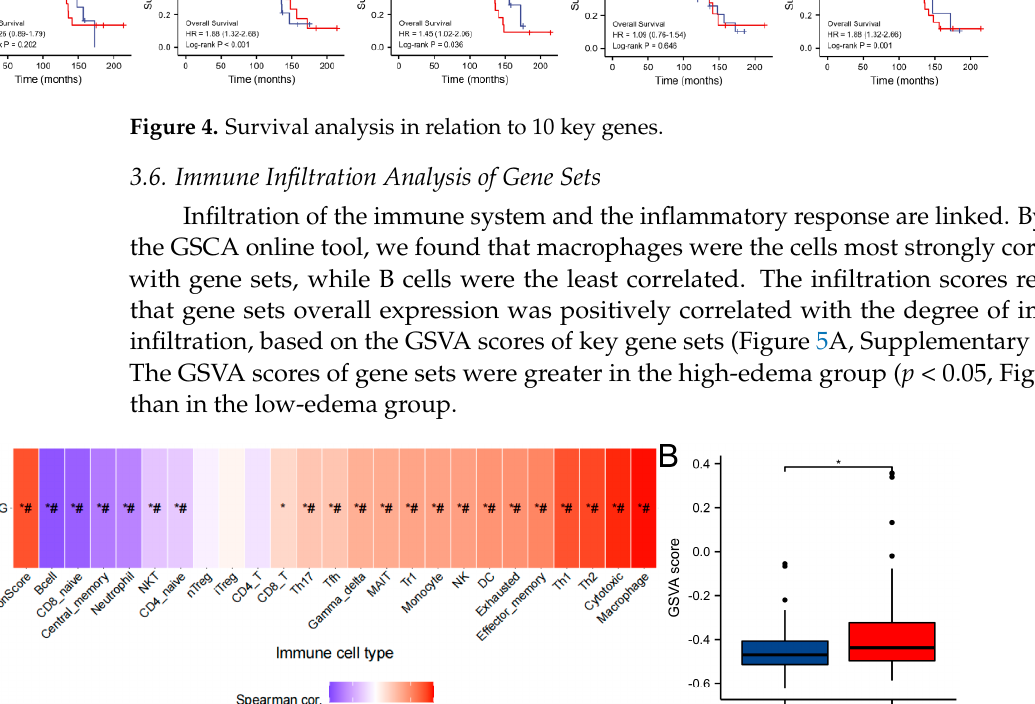
Figure 4. Survival analysis in relation to 10 key genes.